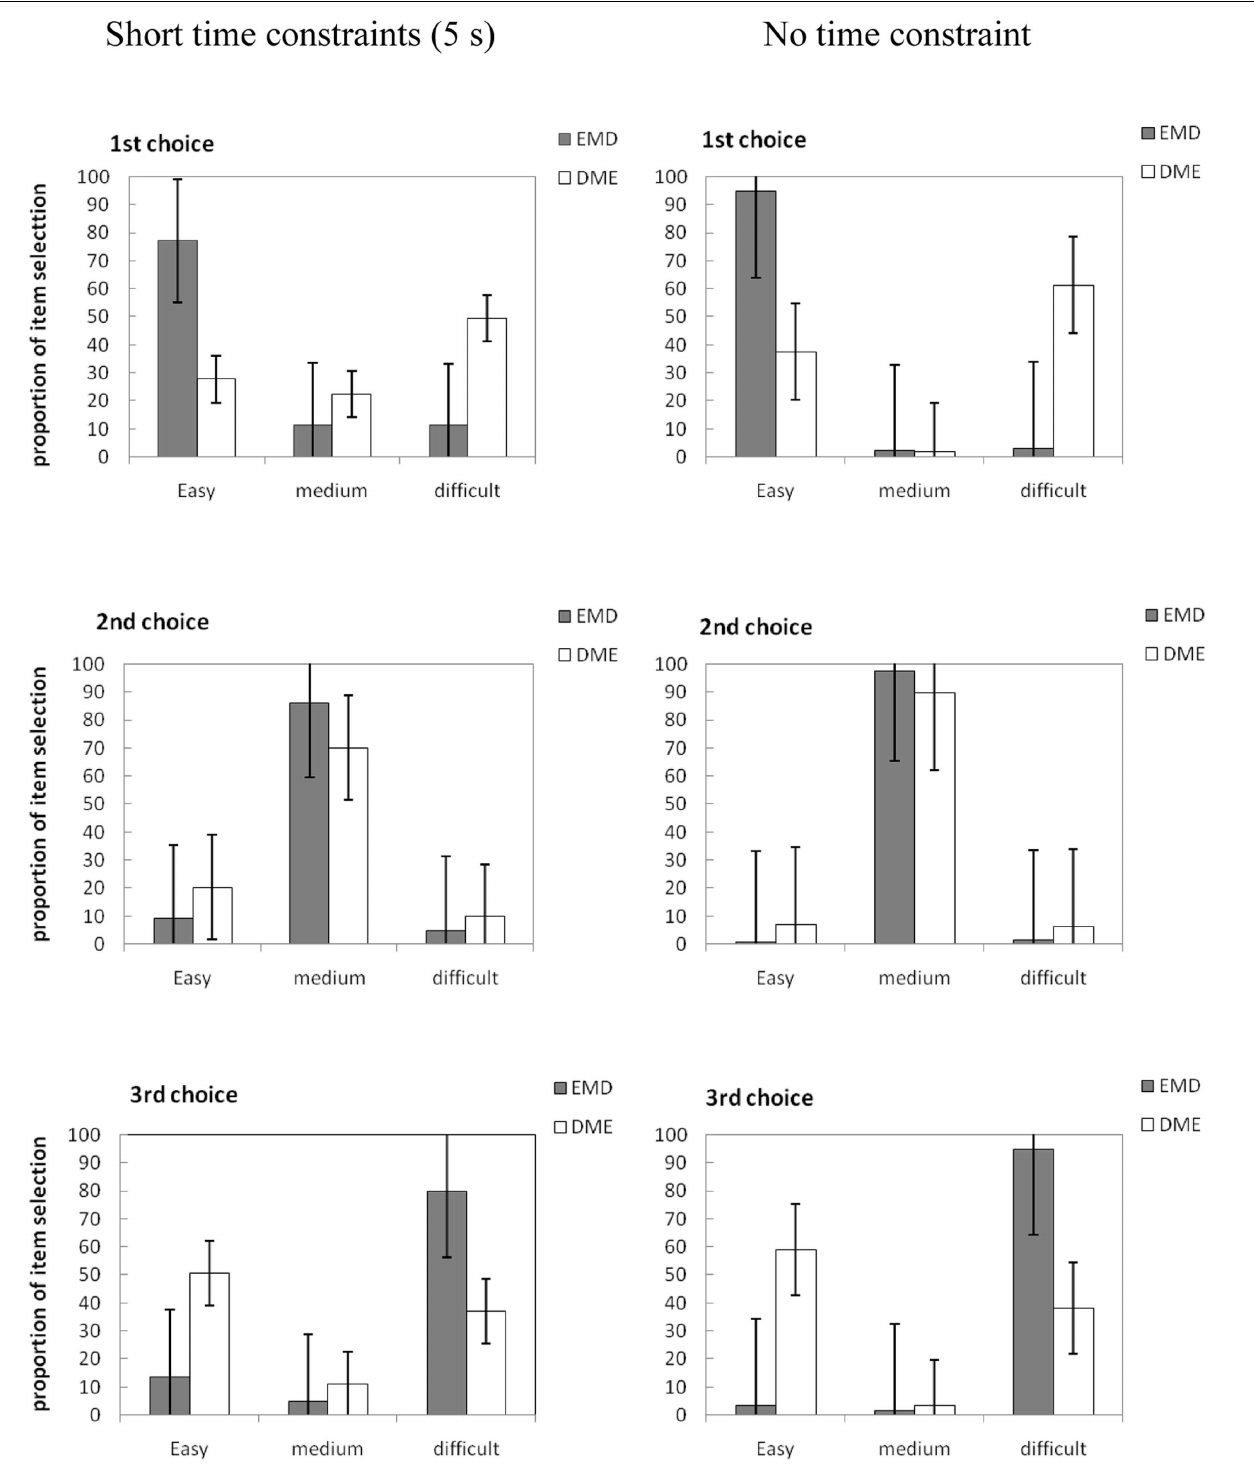
FIGURE 1 | Mean proportion of items selected for the first, second, and third choice across the word pair arrays in Experiment 1. E, easy word pair; M, moderately difficult word pair; D, difficult word pair. Error bars are standard errors of each mean.